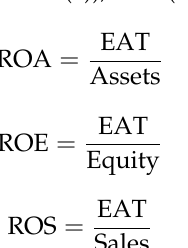
Figure 4. Select profitability measures. Source: own research .